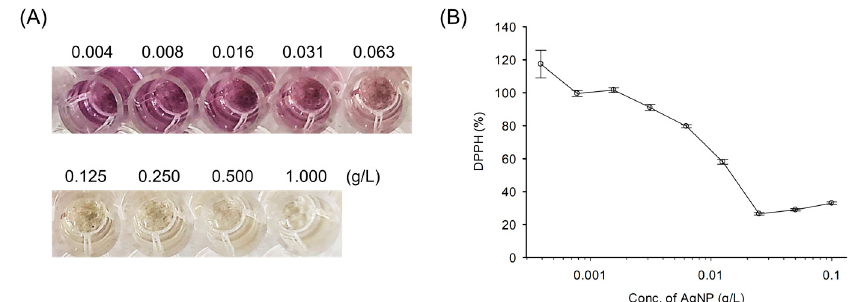
Figure 5. Antioxidant activity of AgNPs against DPPH radicals. ( A ) Photograph of DPPH radicals scavenging assay. ( B ) DPPH radical scavenging activities of AgNPs at various concentrations.